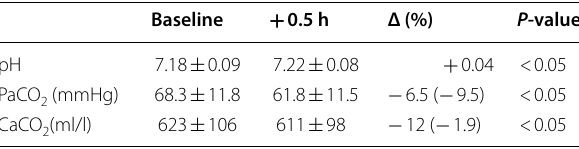
Table 3 Changes in arterial CO and pH between baseline and at 0.5